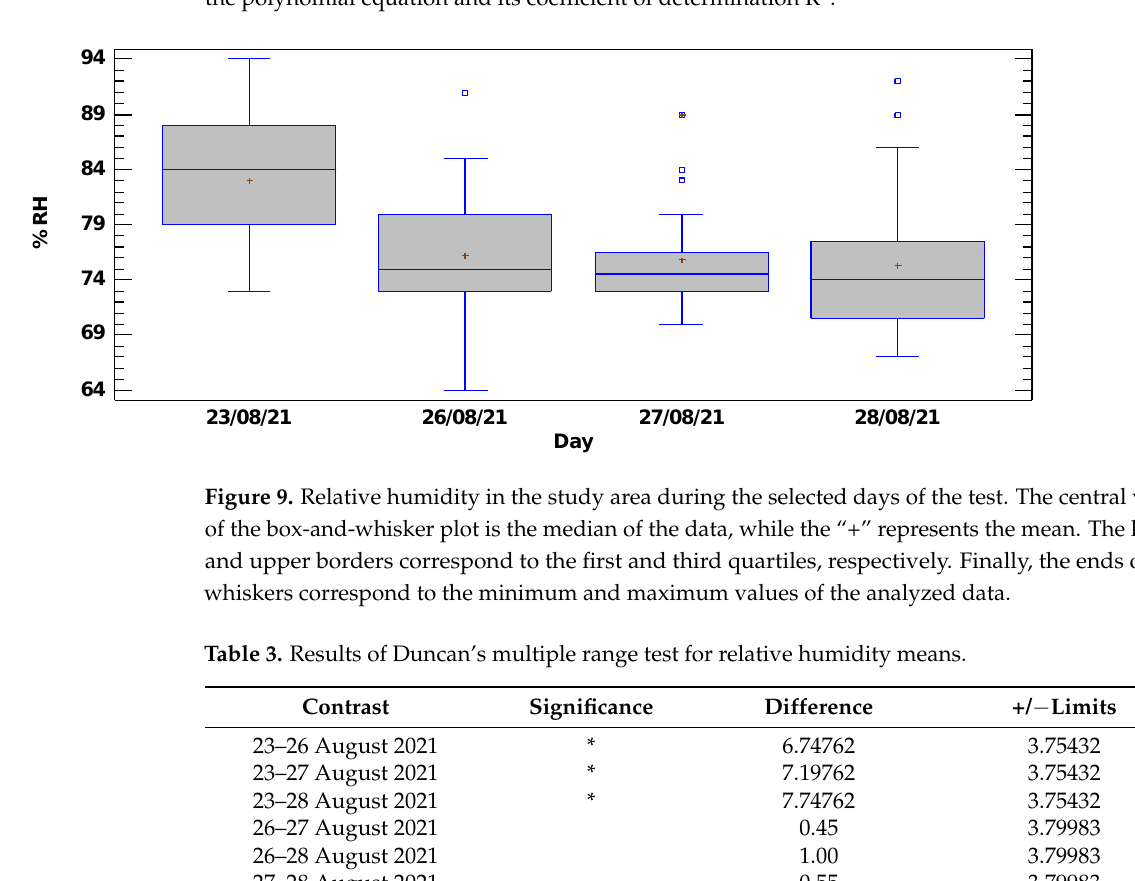
Figure 8. Average solar intensity during field trials. The continuous line represents the average experimental values of solar radiation, recorded every hour during the monitoring days. The dashed-dotted line represents the third-degree polynomial trend line of the experimental values, including the polynomial equation and its coefficient of determination R 2 .